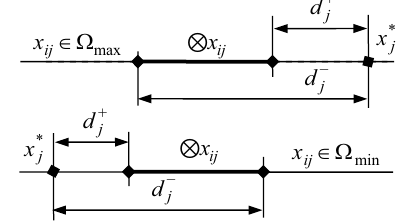
Fig. 6. The distances between the grey performance rating and crisp ideal point